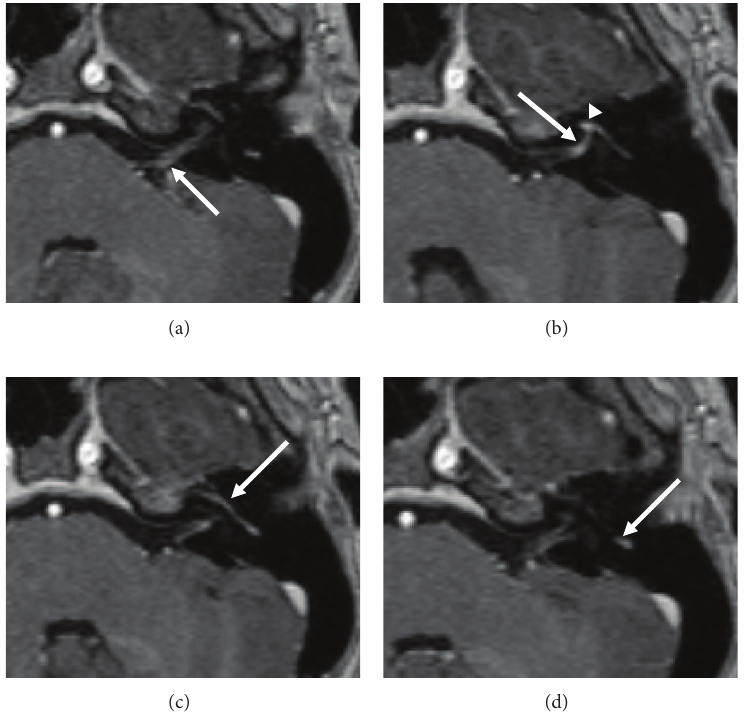
Figure 4: Bell’s palsy. T1- weighted contrast-enhanced MR images demonstrate abnormal enhancement of the distal left cisternal (arrow, (a)), labyrinthine (arrow, (b)), first genu (arrowhead, (b)), and mastoid (arrow, (d)) segment of the facial nerve. Enhancement of the first genu, tympanic and mastoid segments was asymmetrically greater than the normal contralateral side (not